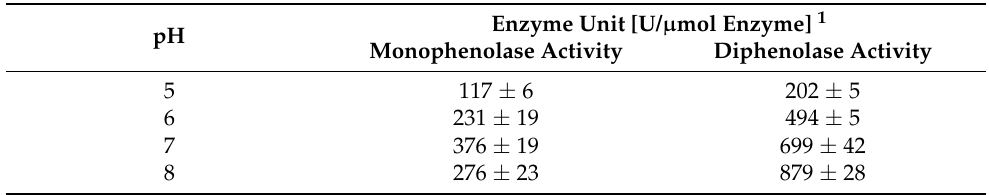
Table 1. Enzyme units of Bm Ty’s two activities at various pH